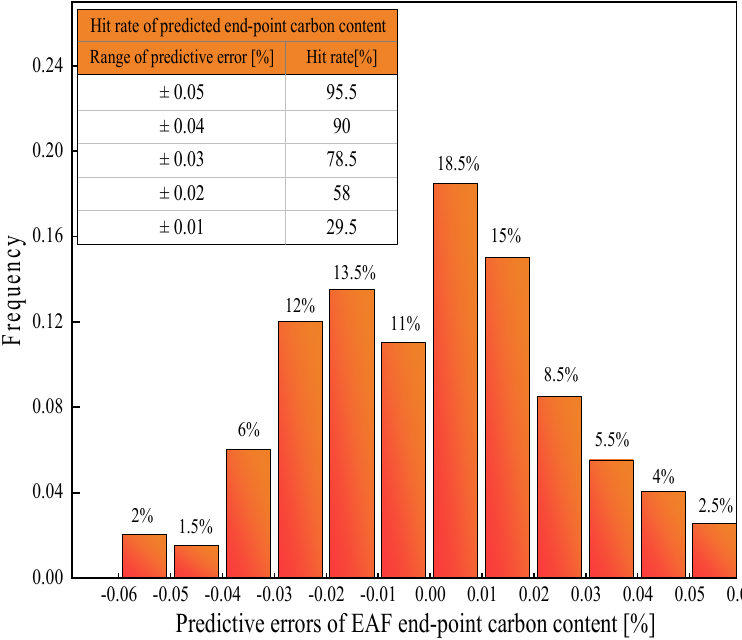
Figure 8. Frequency distribution of predictive errors for improved ANN model.